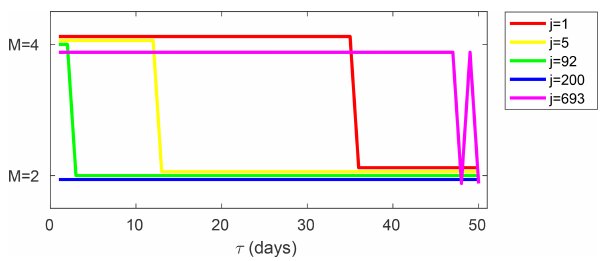
Figure 6. Order of the model for the probability density function of the FTLE (cid:51) (τ) . j